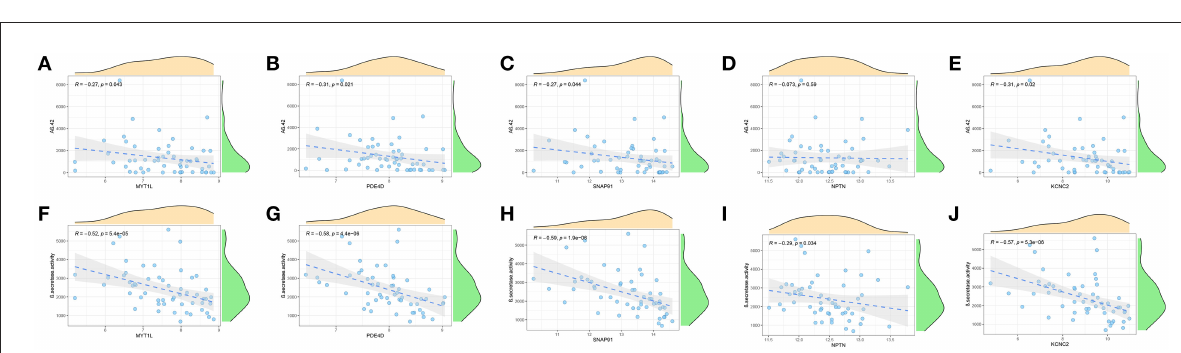
FIGURE10 Validation of correlation analysis based on GSE106241 dataset. (A-E) Correlation between MYT1L (A) , PDE4D (B) , SNAP91 (C) , NPTN (D) , KCNC2 (E) , and A β -42 levels. (F–J) Correlation between MYT1L (F) , PDE4D (G) , SNAP91 (H) , NPTN (I) , KCNC2 (J) , and β -secretase